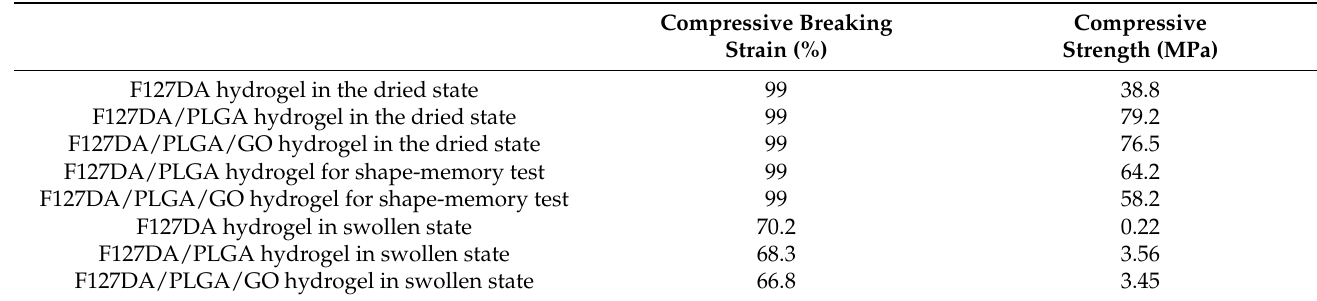
Table 4. Mechanical properties of hydrogels. Reprinted with permission from Ref. [132]. Copyright 2019, Dai, W.